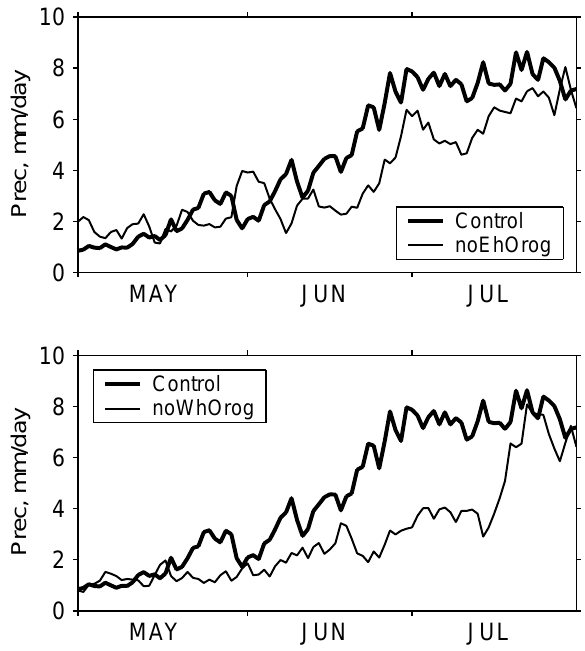
Fig. 9. Evolution of rainfall over Indian region in the control , noWhOrog and noEhOrog